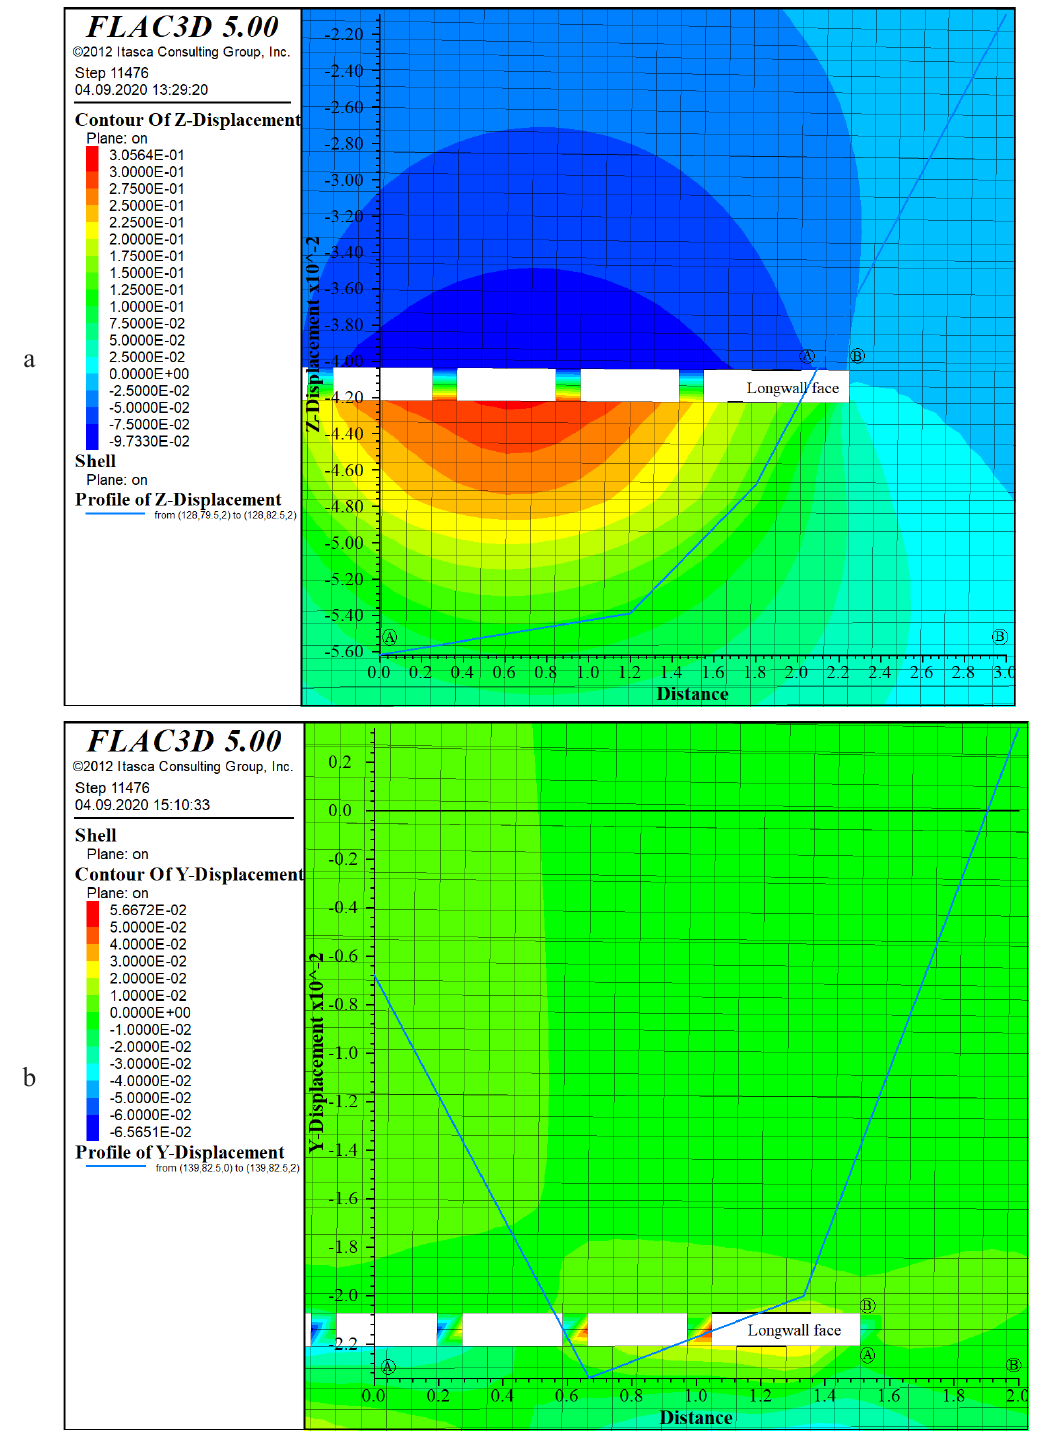
Figure 14: Displacement around the longwall face using the Mohr–Coulomb model: a) vertical displacement along the tip-to-face distance, b) horizontal displacement along the longwall